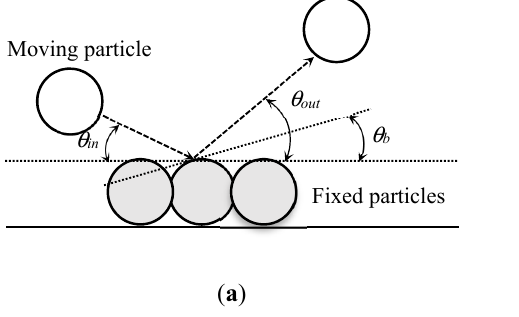
Figure 13. Definition of the collision angles in particle movement process. ( a ) Definition of θ in and θ out ; ( b ) definition of θ b .